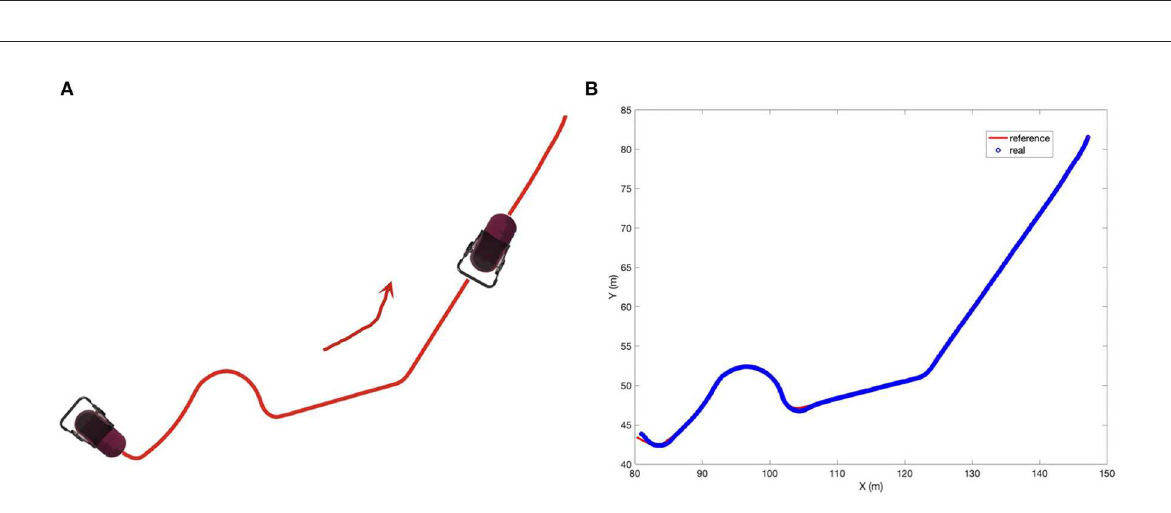
FIGURE13 (A) The illustration of experimental setup for an arbitrary path tracking task for the baby stroller control. (B) Experimental results of following an arbitrary